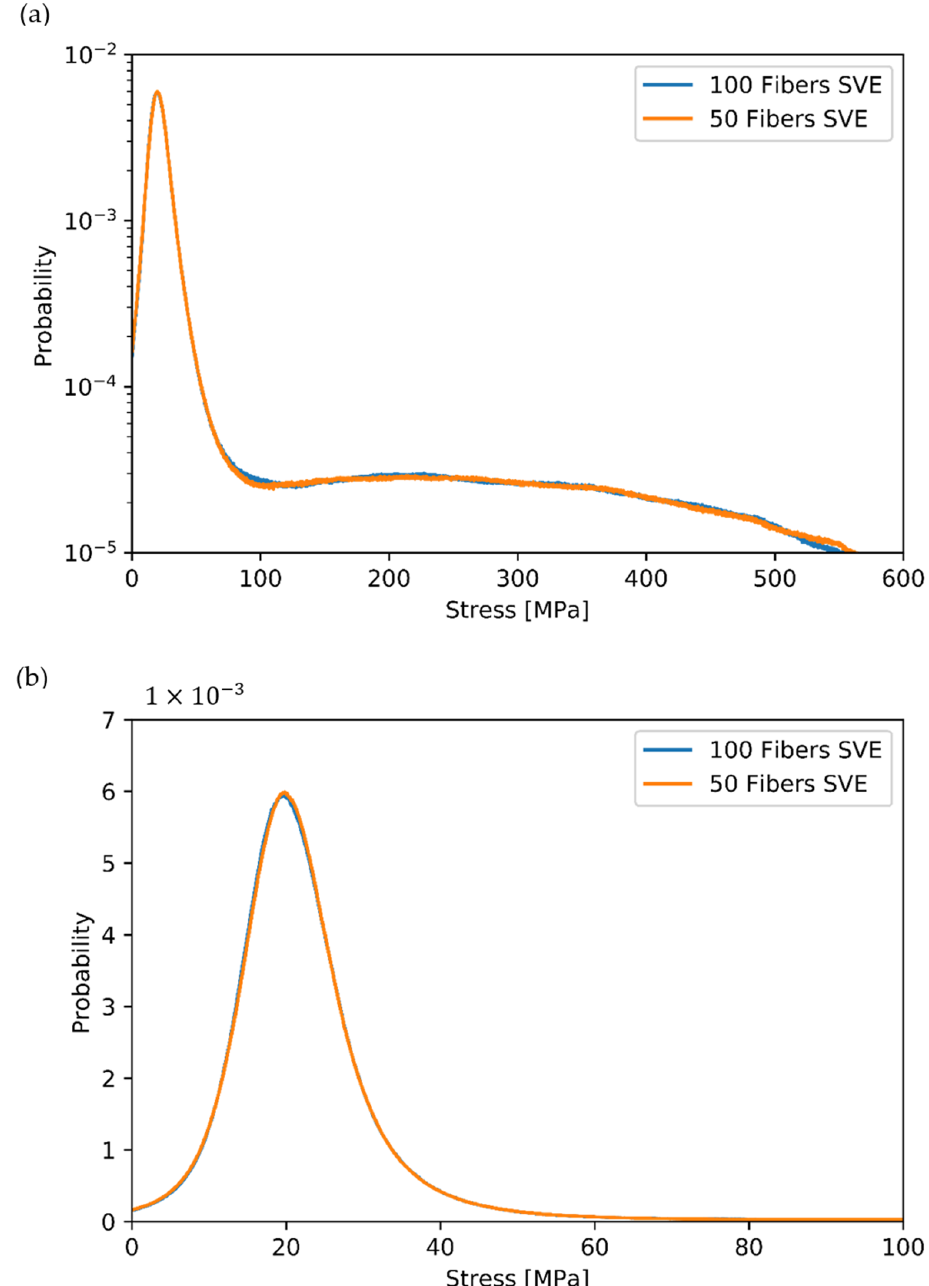
Figure 11. ( a ) Average stress distribution of the composite with 50 and 100 fibers (top). ( b ) Average stress distribution in the matrix phase with 50 and 100 fibers (bottom).